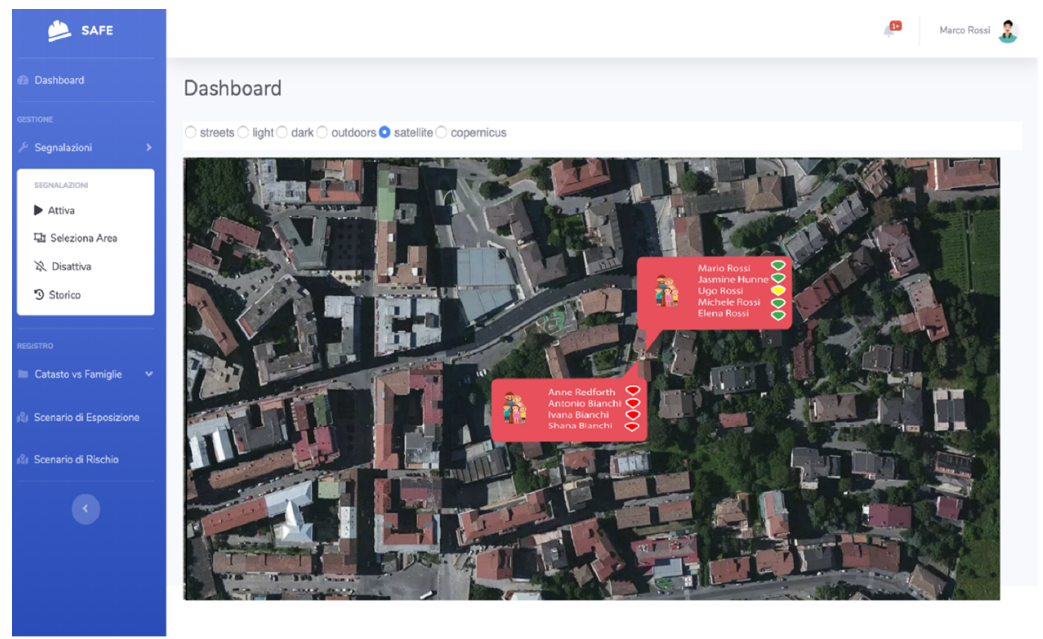
Figure 21. The states of each family members.